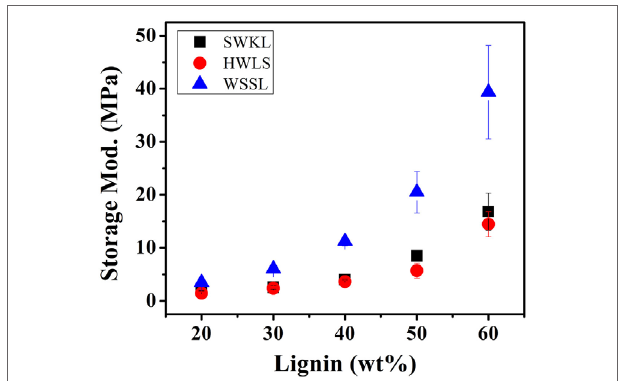
FigUre 6 | Storage modulus values of the lignin-based polyurethane samples obtained using dynamic mechanical